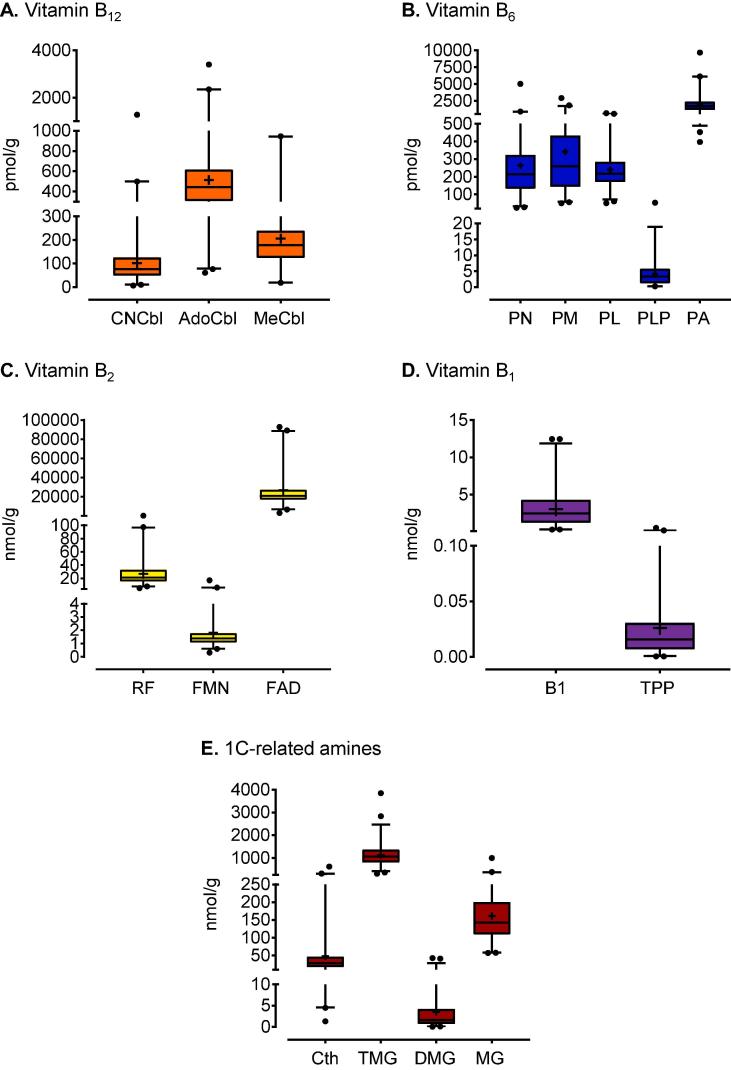
Concentrations of B vitamins in sheep liver. CNCbl, cyanocobalamin; AdoCbl, adenosylcobalamin; MeCbl, methylcobalamin (A). PM, pyridoxamine; PN, pyridoxine; PL, pyridoxal; PLP, pyridoxal 5′-phosphate; PA, pyridoxic acid (B). RF, riboflavin; FMN, flavin mononucleotide; FAD, flavin adenine dinucleotide (C). B1, thiamine; TPP, thiamine pyrophosphate (D). Cth, cystathionine; TMG, trimethylglycine; DMG, dimethylglycine; MG, methylglycine (E). Boxplots depict mean (+), median and interquartile ranges with whiskers set at 1st and 99th percentiles.